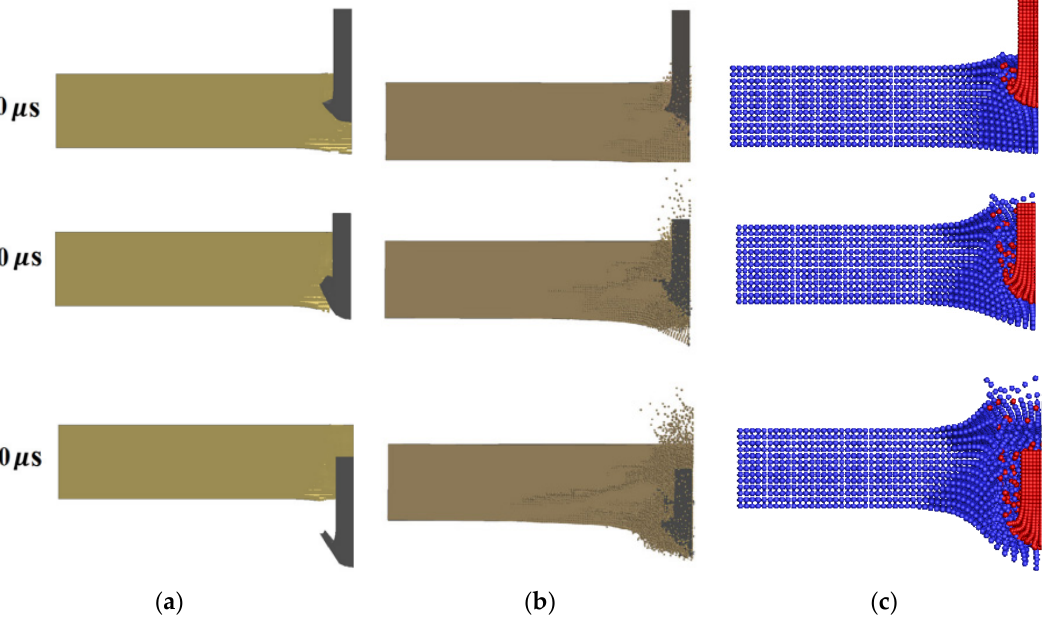
Figure 19. Comparison between the present SPH simulation result and the simulation results of Bresciani et al. with two different approaches: ( a ) FEM with erosion technique [1]; ( b ) Fragmentation approach (7 radial sectors for projectile) [1]; ( c ) The present SPH method.